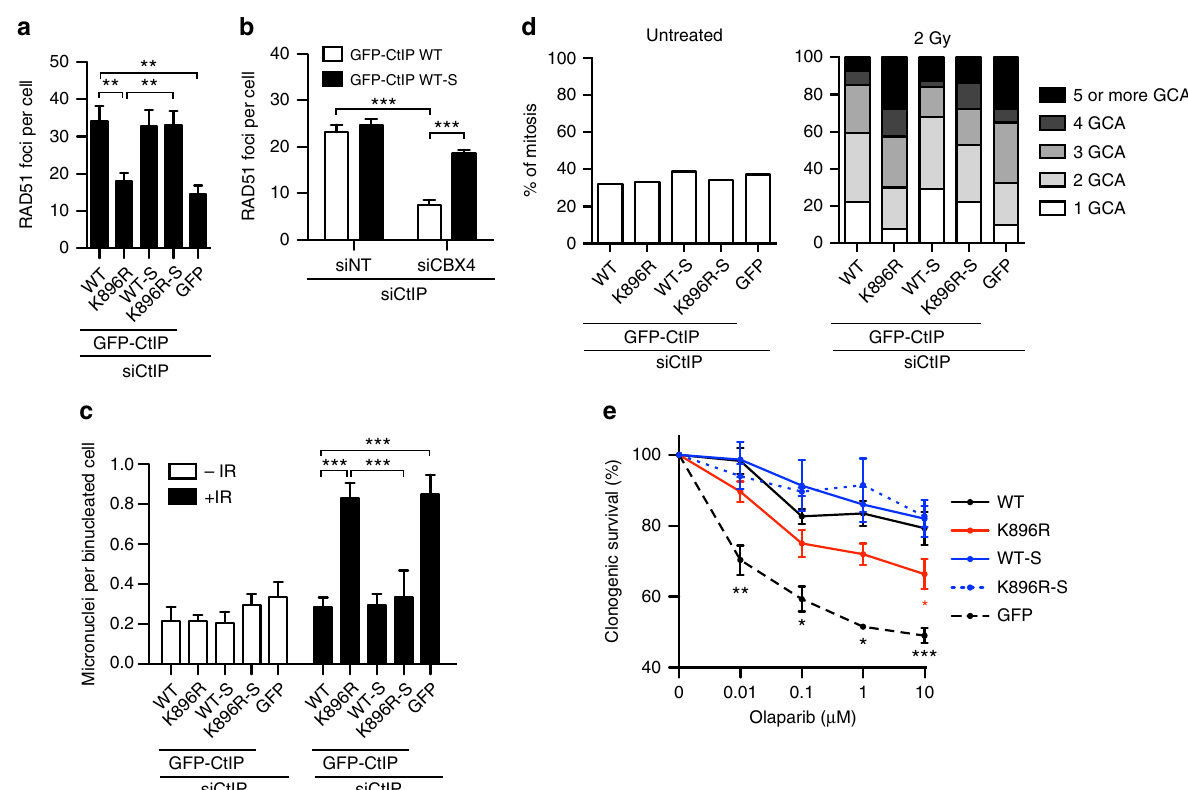
Fig. 4 CtIP sumoylation at K896 contributes to genomic stability maintenance. a Average number of RAD51 foci per nuclei was analyzed 3 h after IR in U2OS cells stably expressing GFP or GFP-CtIP variants and knocked down for endogenous CtIP. RAD51 foci were scored in 100 cells per experiment. Average and SEM of three independent experiments is shown, and statistically signi fi cant differences were analyzed using one-way ANOVA. b Cells depleted for the indicated genes and expressing either GFP-CtIP or GFP-CtIP-SUMO1 were irradiated and RAD51 foci were scored as in a . Statistical signi fi cance was analyzed using two-way ANOVA. c Micronuclei appearance was scored in 100 binucleated U2OS cells per experiment upon IR or mock treatment. The average and SEM of three independent experiments is shown. One-way ANOVA analysis was performed within the irradiated samples. d Gross chromosomal aberrations (GCAs) were scored in GFP or GFP-CtIP expressing U2OS cells. The percentage of mitoses showing the different numbers of GCRs was calculated by analyzing 50 mitoses per experiment either in untreated (left) or treated cells with 2 Gy of IR. A representative experiment out of 3 independent repeats is shown. e Clonogenic survival of GFP or GFP-CtIP expressing U2OS cells upon acute treatment with the indicated dosed of the PARP inhibitor Olaparib. In each experiment, the average number of colonies per condition was scored in six technical replicates and normalized to the mock-treated condition. The average and SEM of three biological independent experiments is shown. Student ’ s t- test between each condition and the wild-type form was performed. For all statistical analyses; * P < 0.5; ** P < 0.05; *** P <